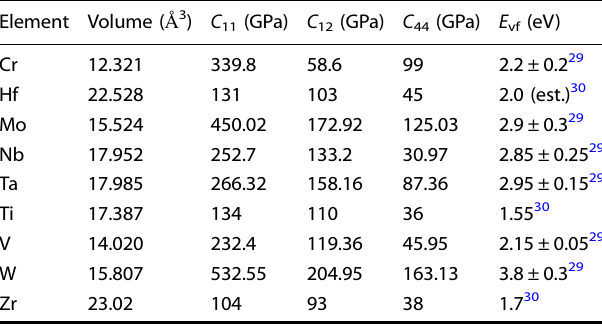
Table 2. Single-element properties used in the reduced edge theory predictions.